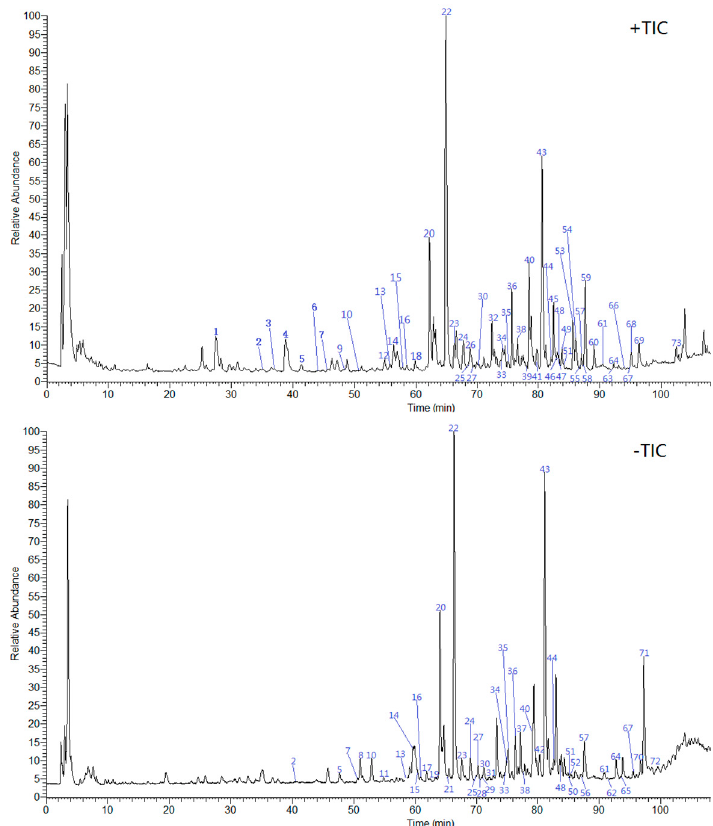
Figure 2. Total ion current (TIC) chromatograms of HWD. ( + TIC: positive mode; − TIC: negative mode).